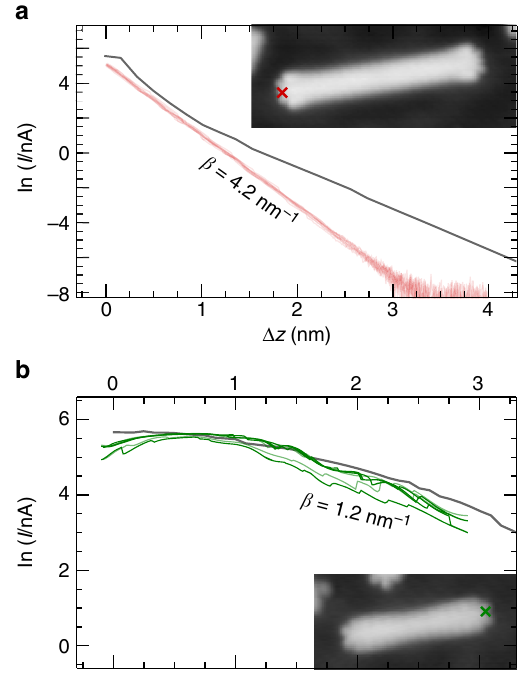
Fig. 4 Conductance measurements on mono-component ribbons. a Experimental ( red ) and theoretical ( gray ) ln( I /nA)( z ) curves for the 7- GNR(10) shown in the inset . The position from which the GNR was lifted is indicated by a red cross . b Experimental ( green ) and theoretical ( gray ) ln( I /nA)( z ) curves for 5-GNR(6) shown in the inset . The position from which the GNR was lifted is indicated by a green